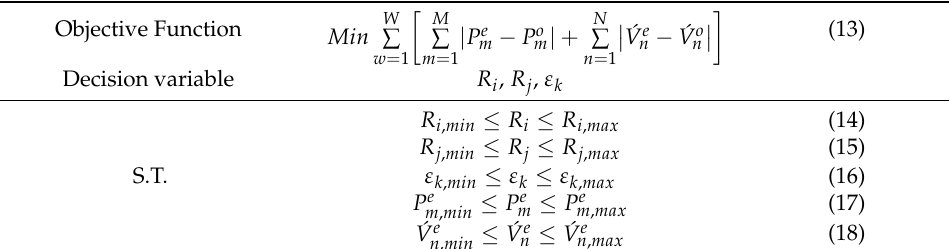
Table 1. The calibration